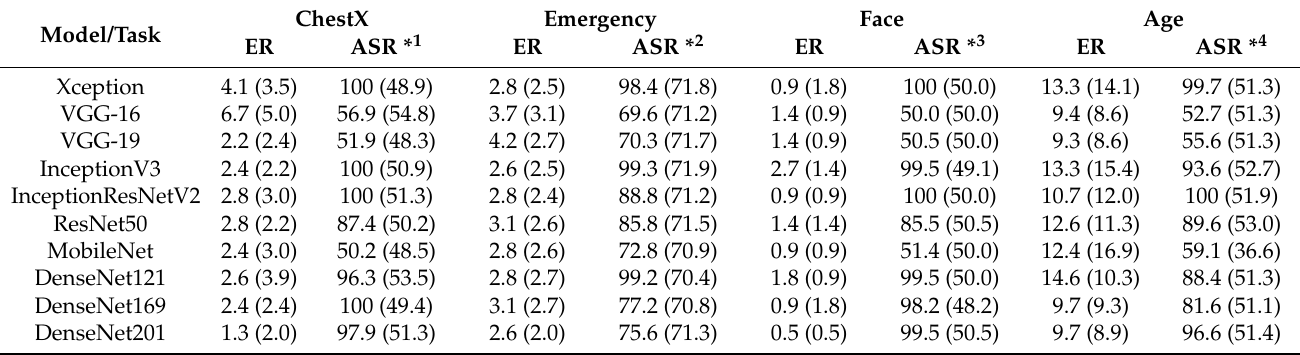
Table 1. Error rate (ER; %) and attack success rate (ASR; %) values for the models from the backdoored ImageNet models for pneumonia classification from chest X-ray images (ChestX), emergency response monitoring from aerial images (Emergency), facial recognition (Face), and age classification from images of faces (Age). Values in brackets are ER and ASR for the models fine-tuned from the clean ImageNet